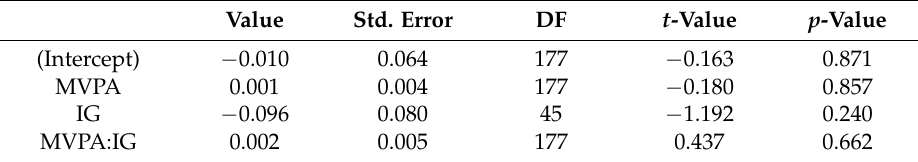
Table A5. Interaction of physical activity on cortisol (segmented 8:30–10:30, 10:30–12:30).